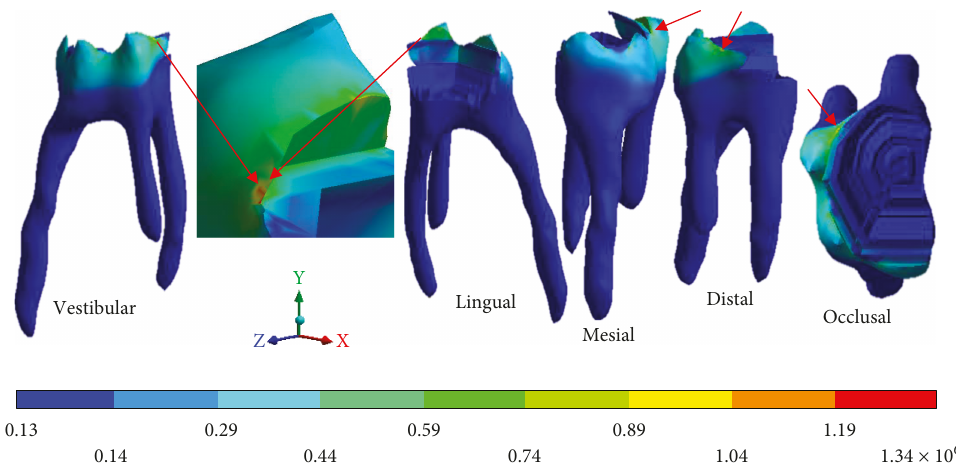
Figure 20: 4th degree caries : von Mises stresses in